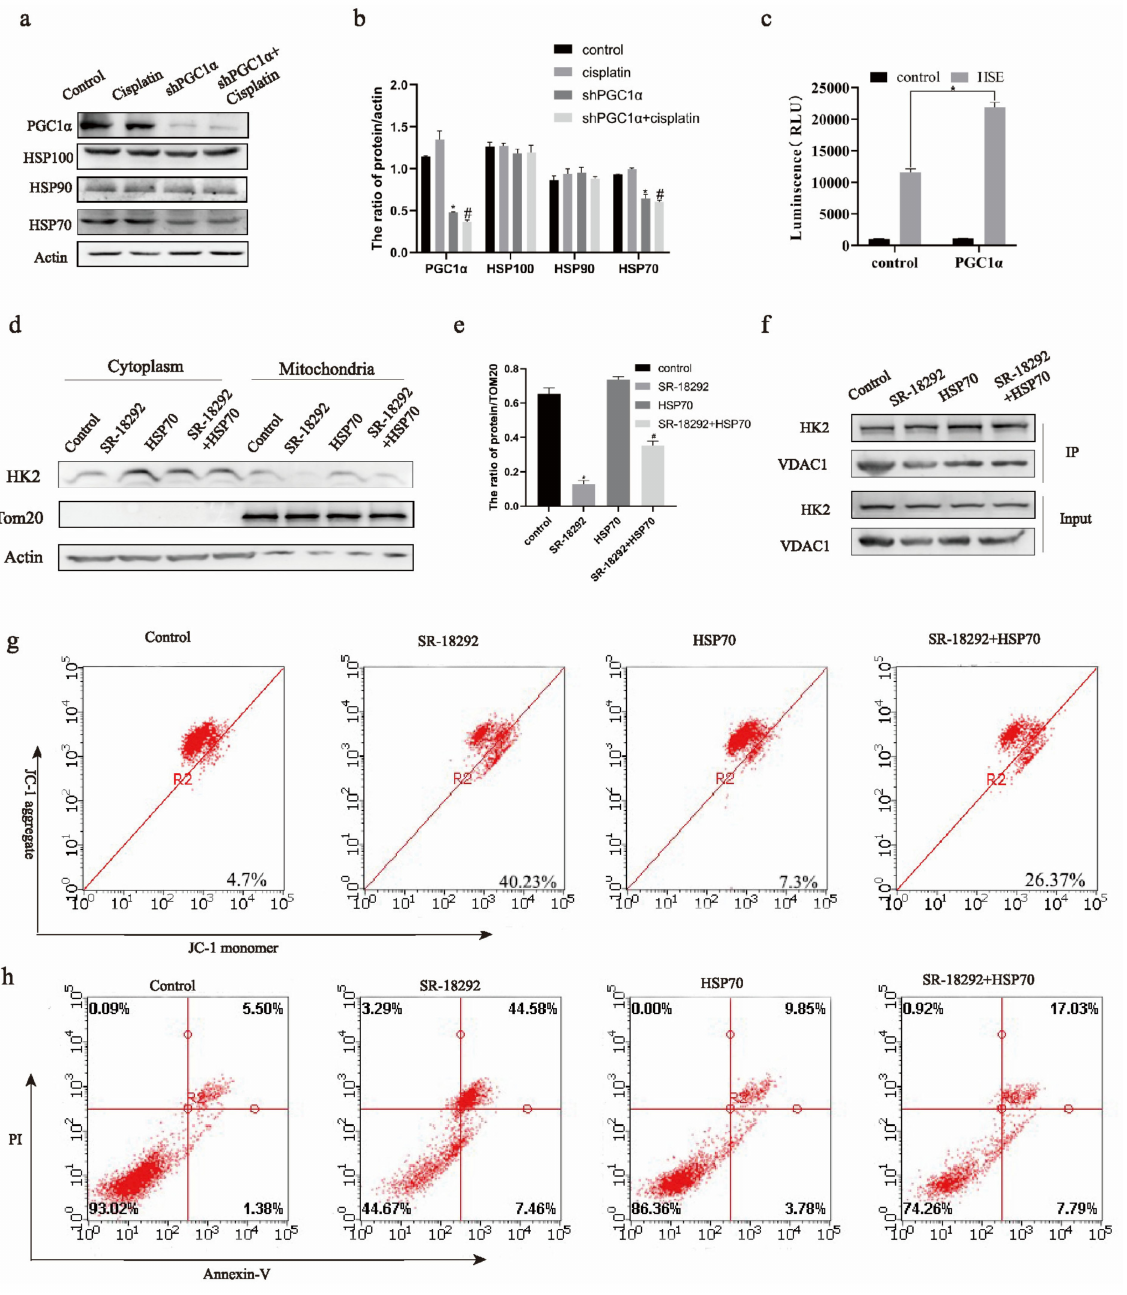
Figure 4. PGC1 α regulates the function of HK2 in mitochondria through heat shock protein 70 (HSP70). The protein expressions of HSP100, HSP90, and HSP70 were detected by Western blot in SKOV3/CDDP cells ( a ). The protein/actin ratio is expressed as the mean ± SD; n = 3, * p < 0.05 vs. control and # p < 0.05 vs. cisplatin ( b ). The luciferase reporter gene was used to detect whether PGC1 α can promote the transcription of HSP70 promoter heat shock factor 1 (HSF1) and expressed as the mean ± SD; n = 3, * p < 0.05 vs. control ( c ). After PGC1 α inhibitor SR-19282 and overexpressed HSP70 at the same time, the mitochondria expressions of HK2 ( d ) were detected. The protein/ translocase of outer mitochondrial membrane 20 (TOM20) ratio is expressed as the mean ± SD; n = 3, * p < 0.05 vs. control and # p < 0.05 vs. SR-18292 ( e ). After PGC1 α inhibitor SR-19282 and overexpressed HSP70 at the same time, the combination HK2–VDAC1 in SKOV3/CDDP cells was detected ( f ). After PGC1 α inhibitor SR-19282 and overexpressed HSP70 at the same time, the mitochondrial membrane potential ( g ) and apoptosis ( h ) in SKOV3/CDDP cells were detected and expressed as the mean ± SD; n =